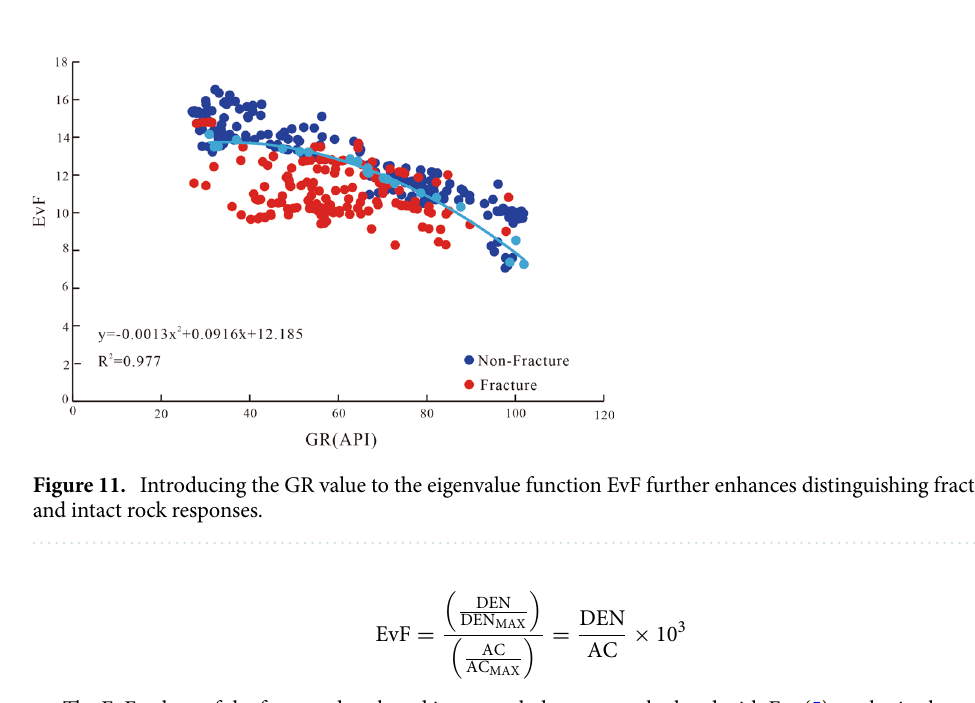
Figure 10. The range of the EvF distribution of fractured and intact rock.